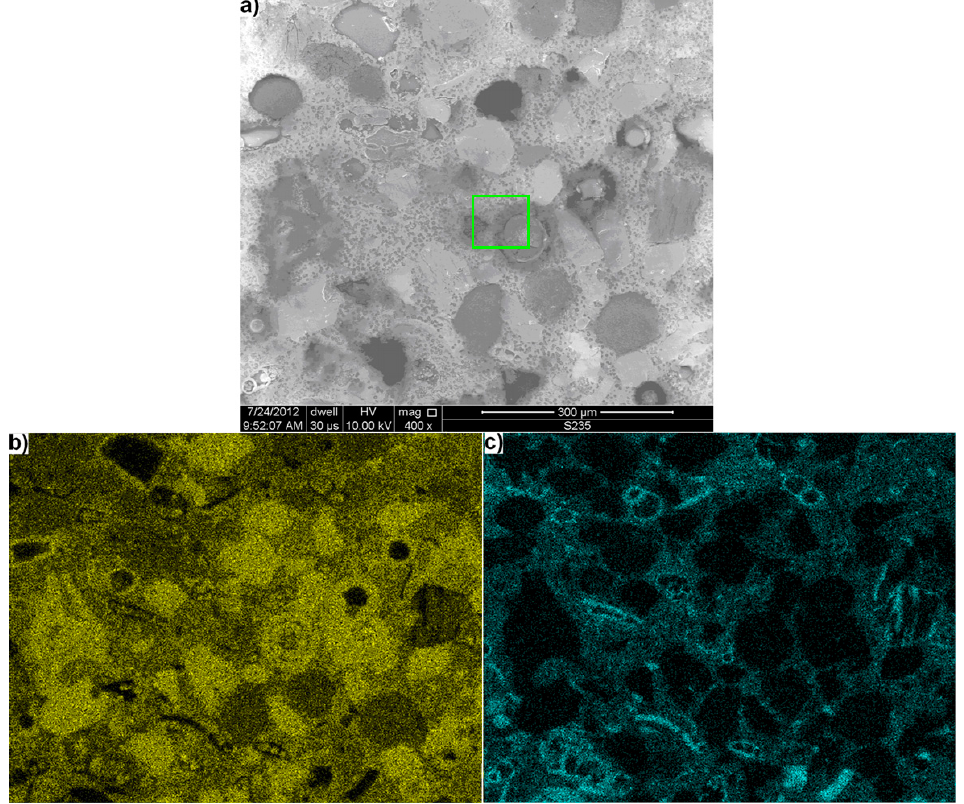
Figure 2. Microstructure of quartz-glaukonitic sandstone with clay-carbonate cement: ( a ) an image at 400× magnification and distribution on its surface (In the green rectangle, is marked the area selected for further analysis on Figure 3), ( b ) Si; and ( c ) Ca.